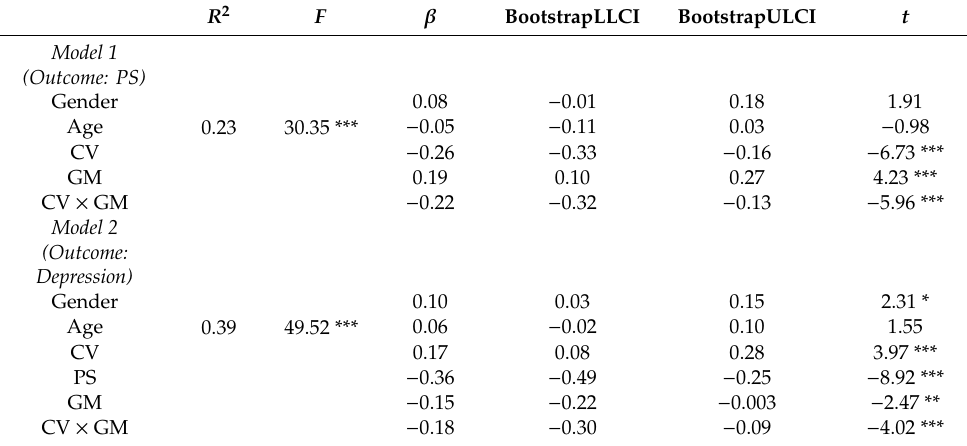
Table 2. Regression models